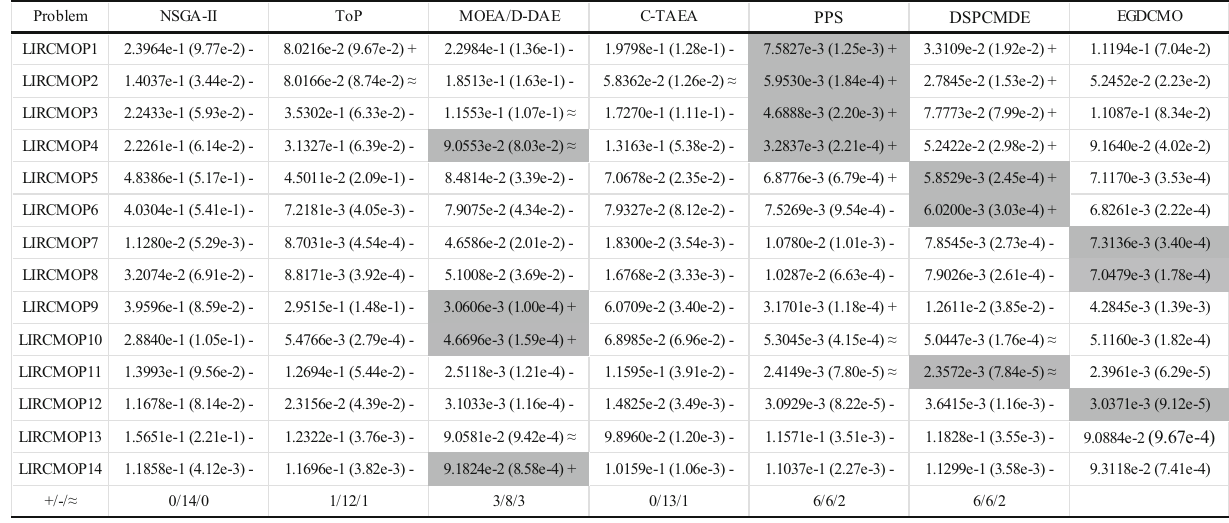
Table 7 Statistics of the IGD metric obtained by the proposed EGDCMO and all the compared CMOEAs on the LIR-CMOP problems OMCDGEAEAT-CEAD-D/AEOMPoTII-AGSNmelborP